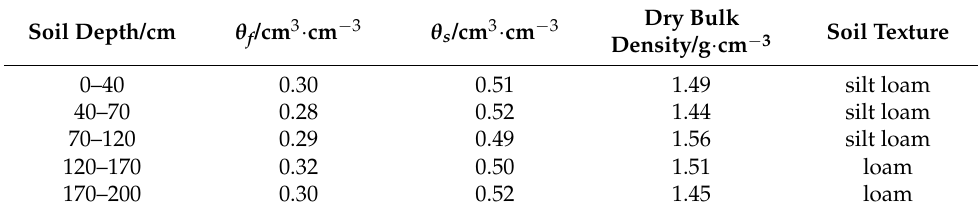
Figure 2. The location of study area. Table 1. Soil physical parameters. Table 1. Soil physical